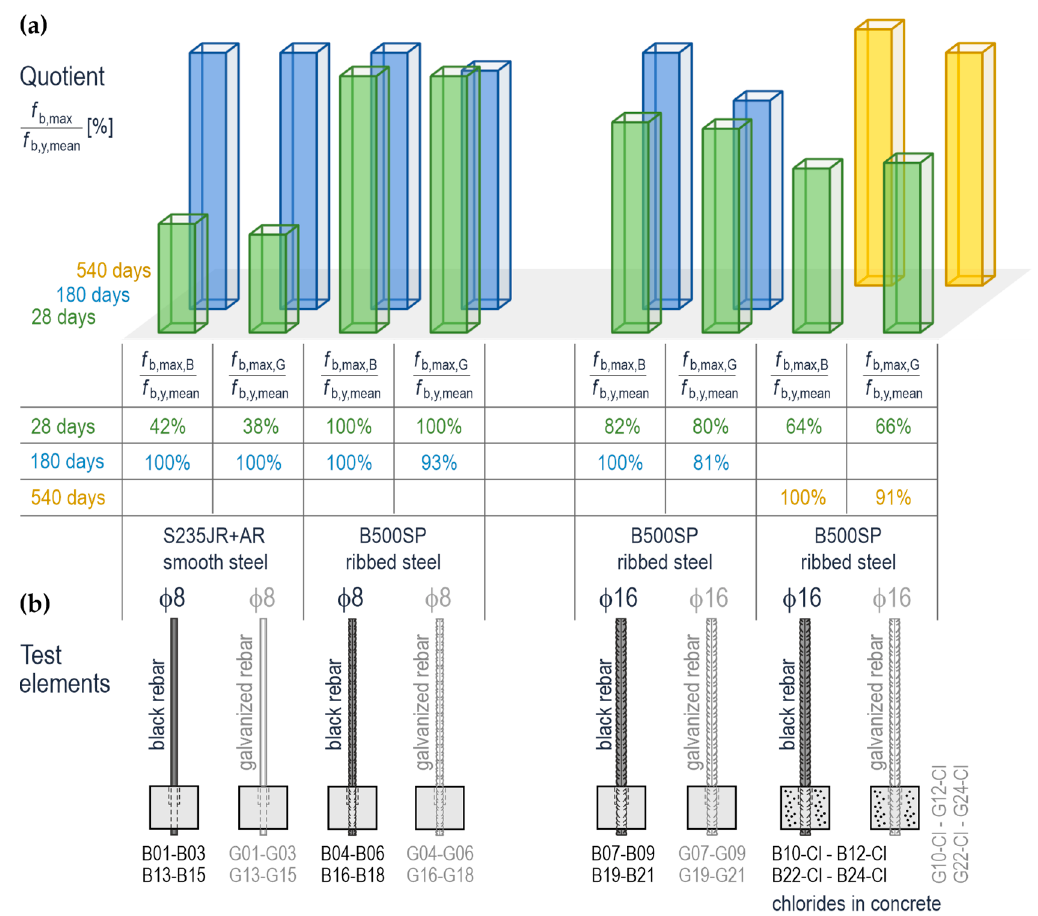
Figure 16. The percentage values determined from the relationship (7) based on the assumption that the parameter f b of adhesive stresses is the random variable: ( a ) quotient f b,max / f b,y,mean expressed as [%], ( b ) the test elements.